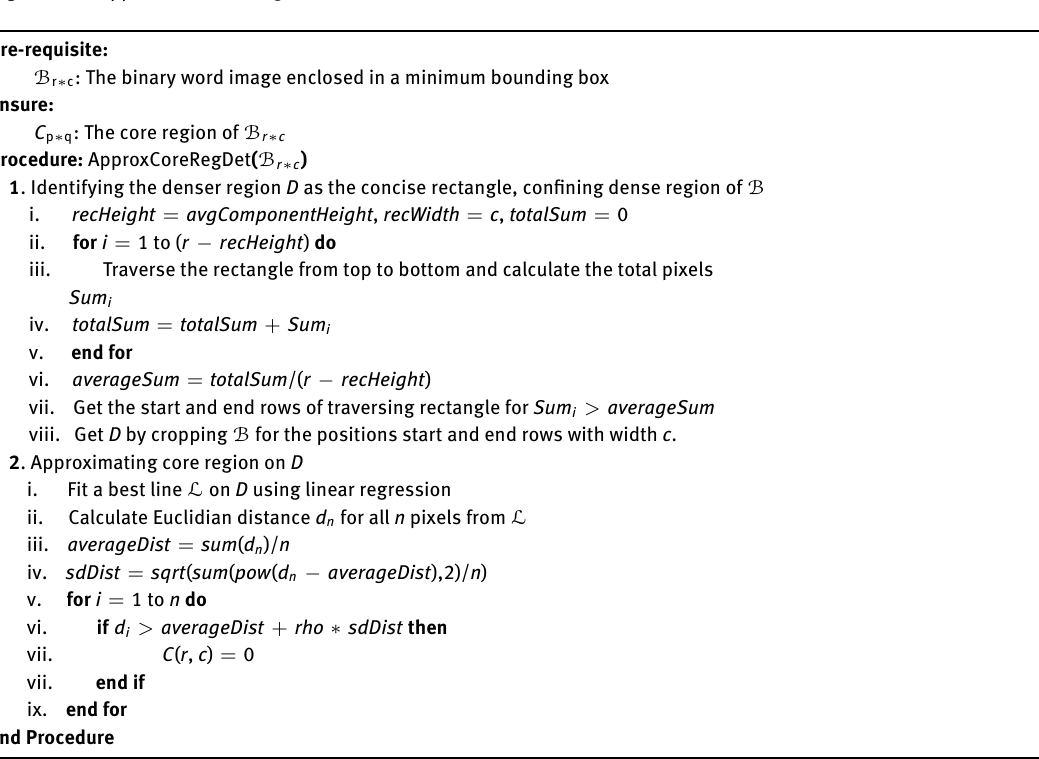
Algorithm 1: Approximate core region